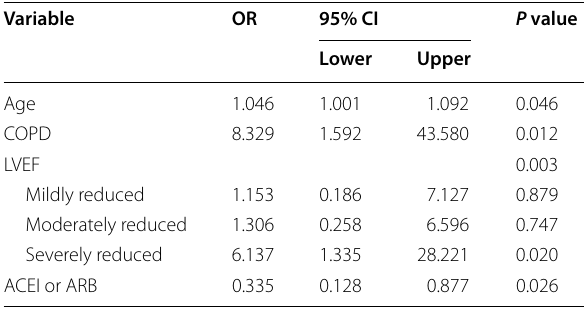
Table 2 Multivariable analysis of the risk factors predicting mortality